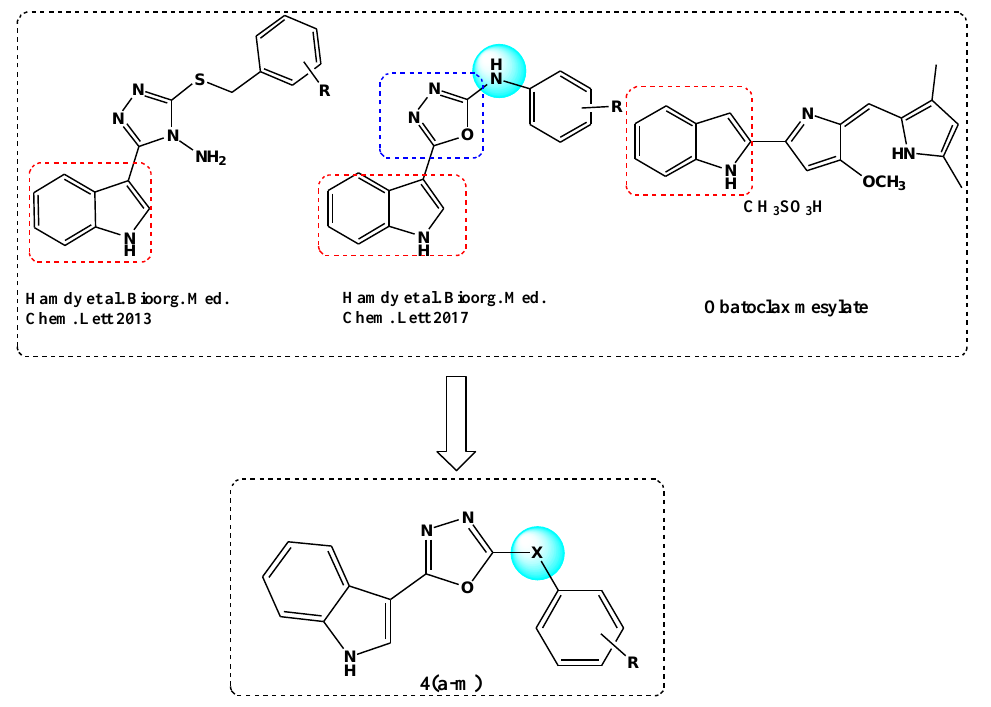
Figure 1. Rational design of novel indole-based oxadiazoles 4a–m.